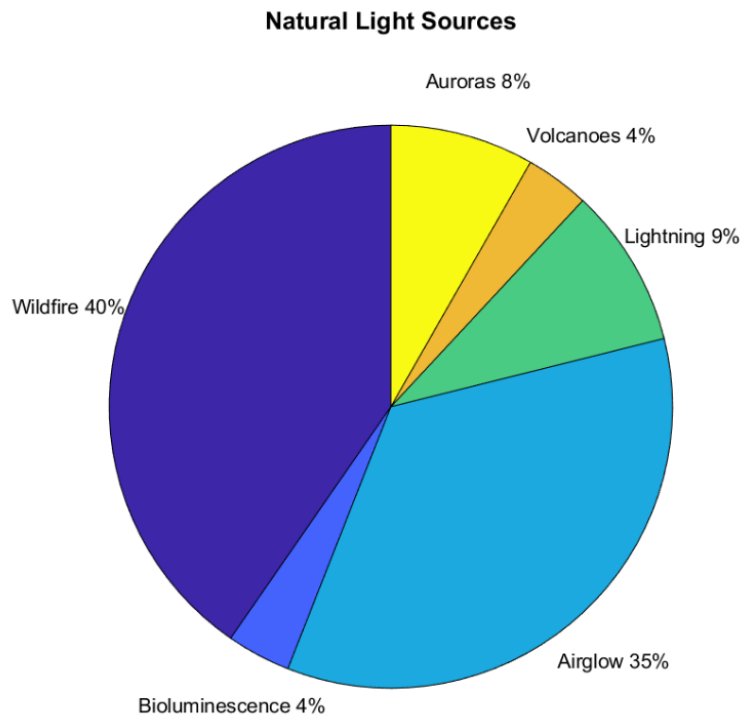
Figure 17. References using natural light sources.